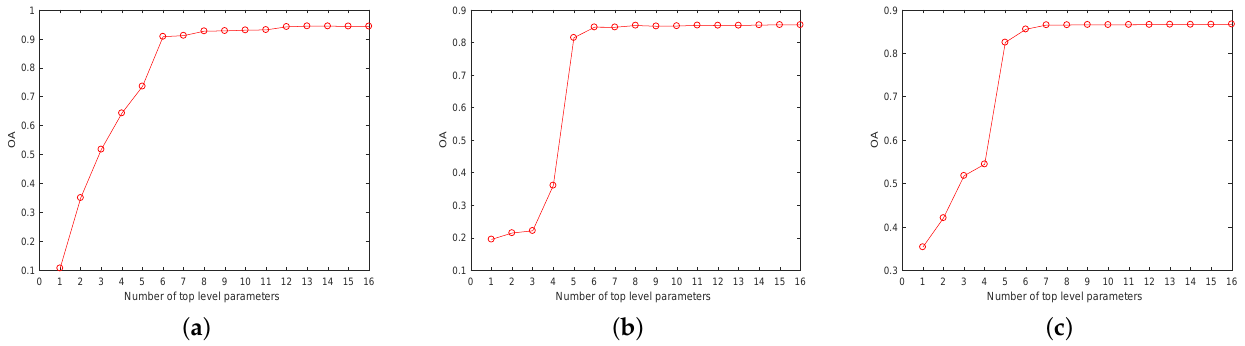
Figure 1. Classification overall accuracy (OA) of artificial neural network (ANN) with increasing parameter subset ( a ) Flevoland, ( b ) Oberpfaffenhofen, and ( c )